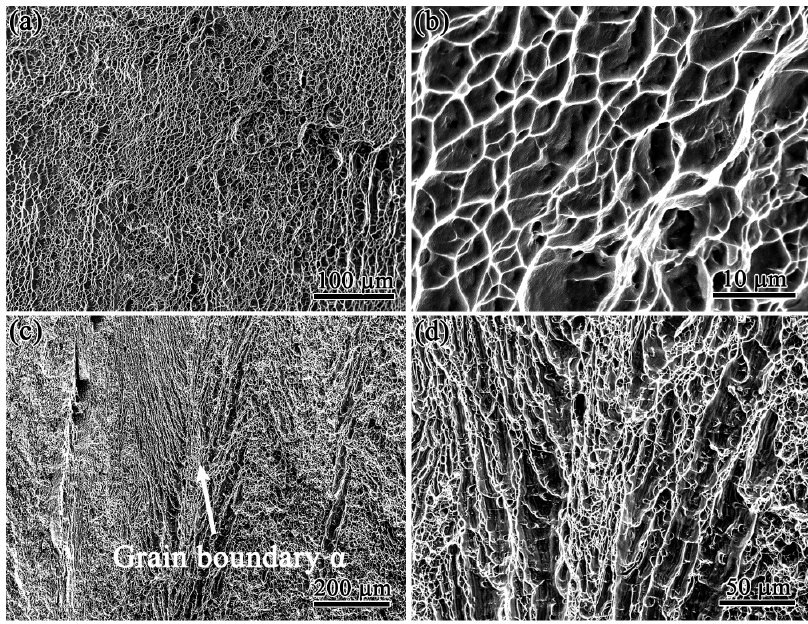
Figure 7. Fracture morphology of the fatigue-damaged samples after 10,000 pre-cycles: ( a ) Low- power and ( b ) high-magnification images of the H-charged sample. ( c ) Low-power and ( d ) high- magnification images of uncharged samples.